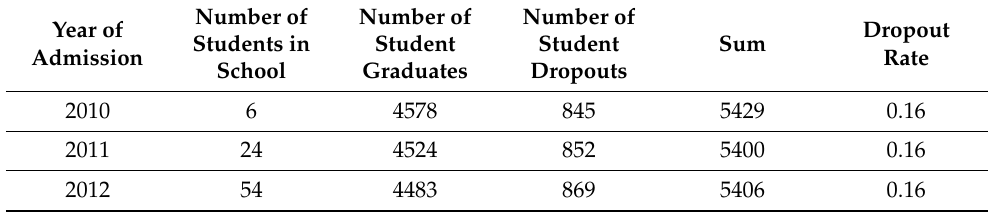
Table 3. Dropout Rate Calculated according to the Cohort